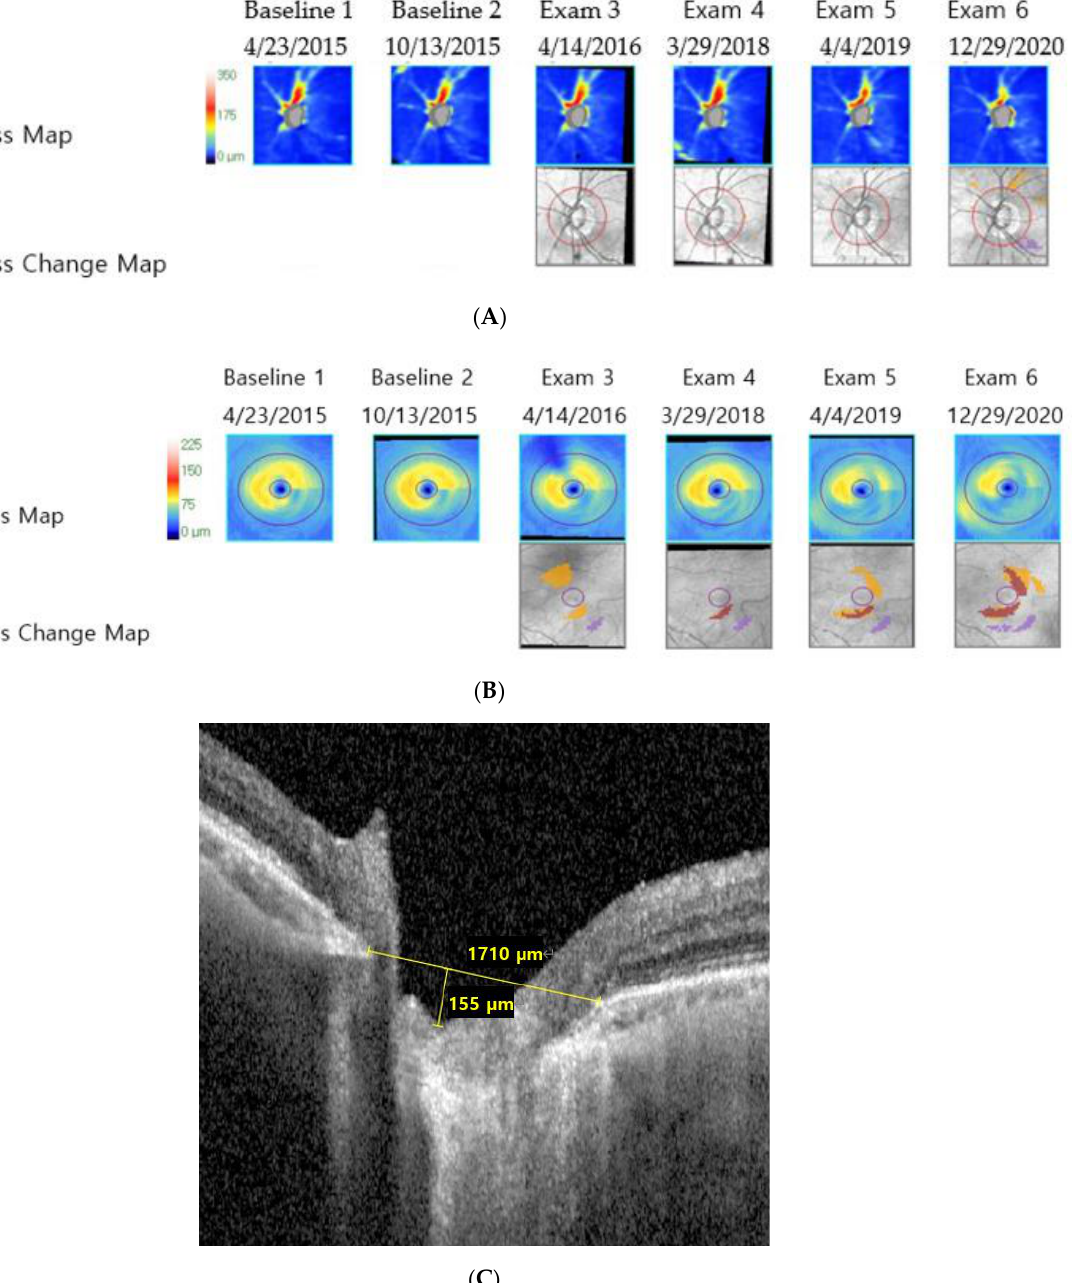
Figure 2. Representative images of a patient with normal-tension glaucoma from the ganglion cell – inner plexiform layer dominant progression group (mean intraocular pressure with Goldmann tonometry: 13.18 mmHg, Axial length: 22.67 mm, visual field mean deviation: − 0.49 dB). ( A ) Retinal nerve fiber layer deviation and thickness-guided progression analysis from Cirrus optical coherence tomography shows stable retinal nerve fiber layer thickness, ( B ) ganglion cell – inner plexiform layer deviation and thickness-guided progression analysis from Cirrus optical coherence tomography shows progressive ganglion cell – inner plexiform layer thickness loss, and ( C ) infrared image of lam- ina cribrosa from Spectralis optical coherence tomography shows small lamina cribrosa curvature index. 4. Discussion Recent advancements in OCT segmentation algorithms have enabled the visualiza- tion and measurement of individual retinal layer thickness, including the RNFL and GCIPL. Therefore, this enabled the structure – function relationships to be improved. RNFL defects in glaucomatous damage are well known, and recent studies have demon- strated evidence of early damage to the GCIPL at the macula in some patients with glau- coma [6,7]. Early foveal involvement, which includes GCIPL loss, has been assumed to be more related to factors other than IOP [8 – 10]. This study demonstrated that RNFL-dominant progression was more strongly asso- ciated with pre-treatment IOP, mean IOP, and LCCI than GCIPL-dominant progression. Notably, GCIPL progression was associated with factors other than IOP, including pcMvD, systolic and diastolic blood pressure, the presence of hypertension and diabetes mellitus, and age, although the association was not statistically significant. To the best of our knowledge, many studies have proposed a difference in LC architecture based on the IOP level. Thus, these seem to support the biomechanical theory of glaucoma pathogene- sis. However, no study has categorized patients with glaucoma into RNFL- or GCIPL- dominant progression groups and compared their associated factors. To date, elevated IOP has proven to be the principal manageable risk factor for the development and progression of glaucoma [11 – 13]. However, the exact mechanism of how IOP contributes to the glaucomatous damage is not yet completely understood [11 – 13]. The LC has been considered the primary site of IOP-related pathogenesis in glaucoma [14 – 19]. Furthermore, an experimental study in an early glaucoma model revealed that morphologic changes in the LC preceded damage to the RNFL [14]. However, biomechan- ical changes in the LC are assumed to induce damage to axonal and/or RGCs through